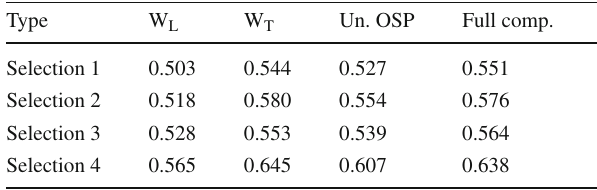
Table 1 Summary of the fractions of correct choices in the semi- leptonic channel for different selection criteria, applied on samples con- taining a purely longitudinally polarized (W L ) leptonically decaying W boson, a purely transversely polarized (W T ) boson, an unpolarized W boson generated in the OSP PHANTOM framework (Un. OSP) and